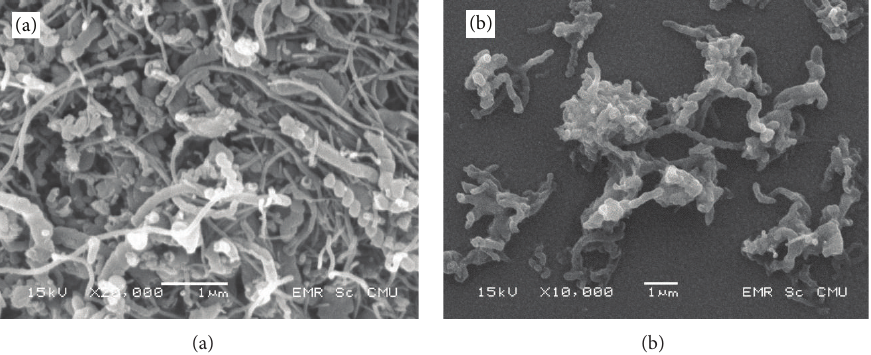
Figure 3: SEM images of (a) MWNTs and (b) PABA/MWNTs composite thin film containing 7.5 mg/mL MWNTs after electropolymerization for 5 cycles in 0.5 MH 2 SO 4